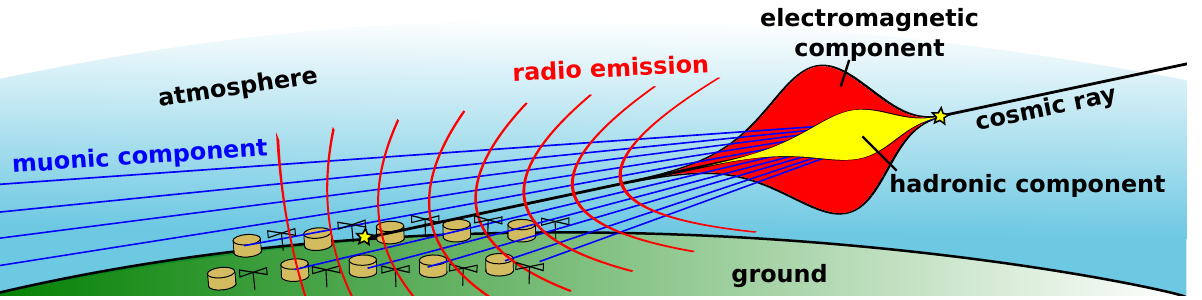
Figure 7. Sketch of a horizontal air shower. The electromagnetic as well as the hadronic air shower components are absorbed in the atmosphere and only muons penetrate to the detectors. The atmosphere is transparent to radiation with frequencies in the 30 − 80 MHz band. (courtesy Ewa Holt)